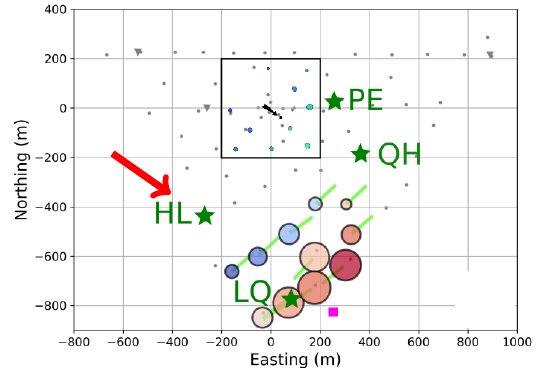
Figure 2: Illustrating event seen by the particle detector and some LF and MF antennas [7]. The event arrival direc- tion is θ = 41 ± 2 ◦ , Φ = 145 ± 1 ◦ , represented by the red arrow, and its energy (3 . 7 ± 0 . 6) × 10 18 eV, from the CO- DALEMA standalone antenna reconstruction. Grey dots represent the standalone antennas, the square area repre- sents the scintillators array region. The stars feature the LF antennas, the involved ones are depicted in green. The involved standalone antennas are represented by coloured circles, whose colour indicates the timing order in which the signal has been seen by the antennas (from blue, earli- est, to red, latest), area of circles reflects the relative am- plitude of the signal (linear scale). The small green lines close to the circles indicate the orientation of the measured polarization of each MF antenna, nearly orthogonal to the direction of arrival of the event as expected from the domi- nant geomagnetic mechanism. The estimated shower core location is represented by the magenta